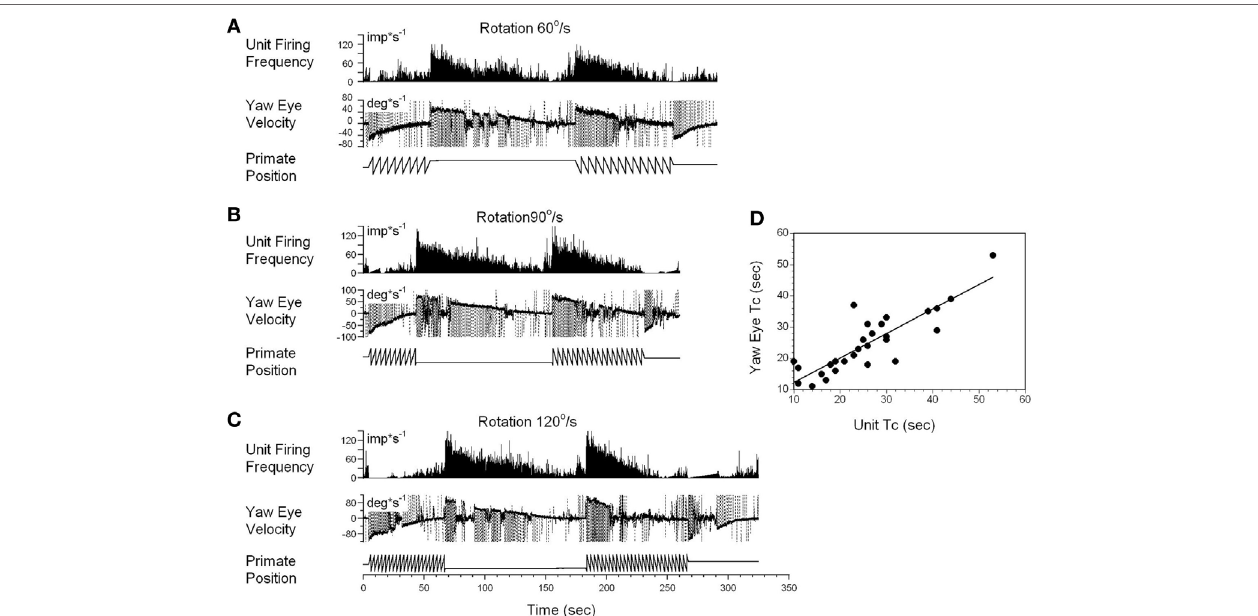
FigUre 5 | Changes in the firing rate of a typical vestibular-only (VO) neuron that codes the yaw component of velocity storage during head rotation at 60°/s (a) , 90°/s (B) , and 120°/s (c) . (a–c) In each section, after being in darkness for 5 s, the animal was rotated to the left (counterclockwise) and then stopped while in darkness (primate position, tooth-like, and constant levels, respectively). Then rotation was repeated in the opposite (clockwise) direction. This sequence induces per-rotatory nystagmus to the right (Negative Eye Velocity) which gradually declined to 0. When rotation was stopped, it induces post-rotatory nystagmus in the opposite direction (positive eye velocity). This sequence of per- and post-rotatory nystagmus was repeated in the opposite directions. The experiment animal was extremely drowsy, and there was a sudden decline of slow phase eye velocities to 0. Drowsiness, however, did not the affect firing rate of this VO neuron. (D) Relationship between the time constants of velocity storage determined from slow the phase eye velocity (ordinate) and from the neuronal firing rate (abscissa). Each data point on this graph represents a time constant measured for the oculomotor response and corresponding neuronal response. This is shown in the two responses in graphs (a–c) . The black line is the linear regression of the data.